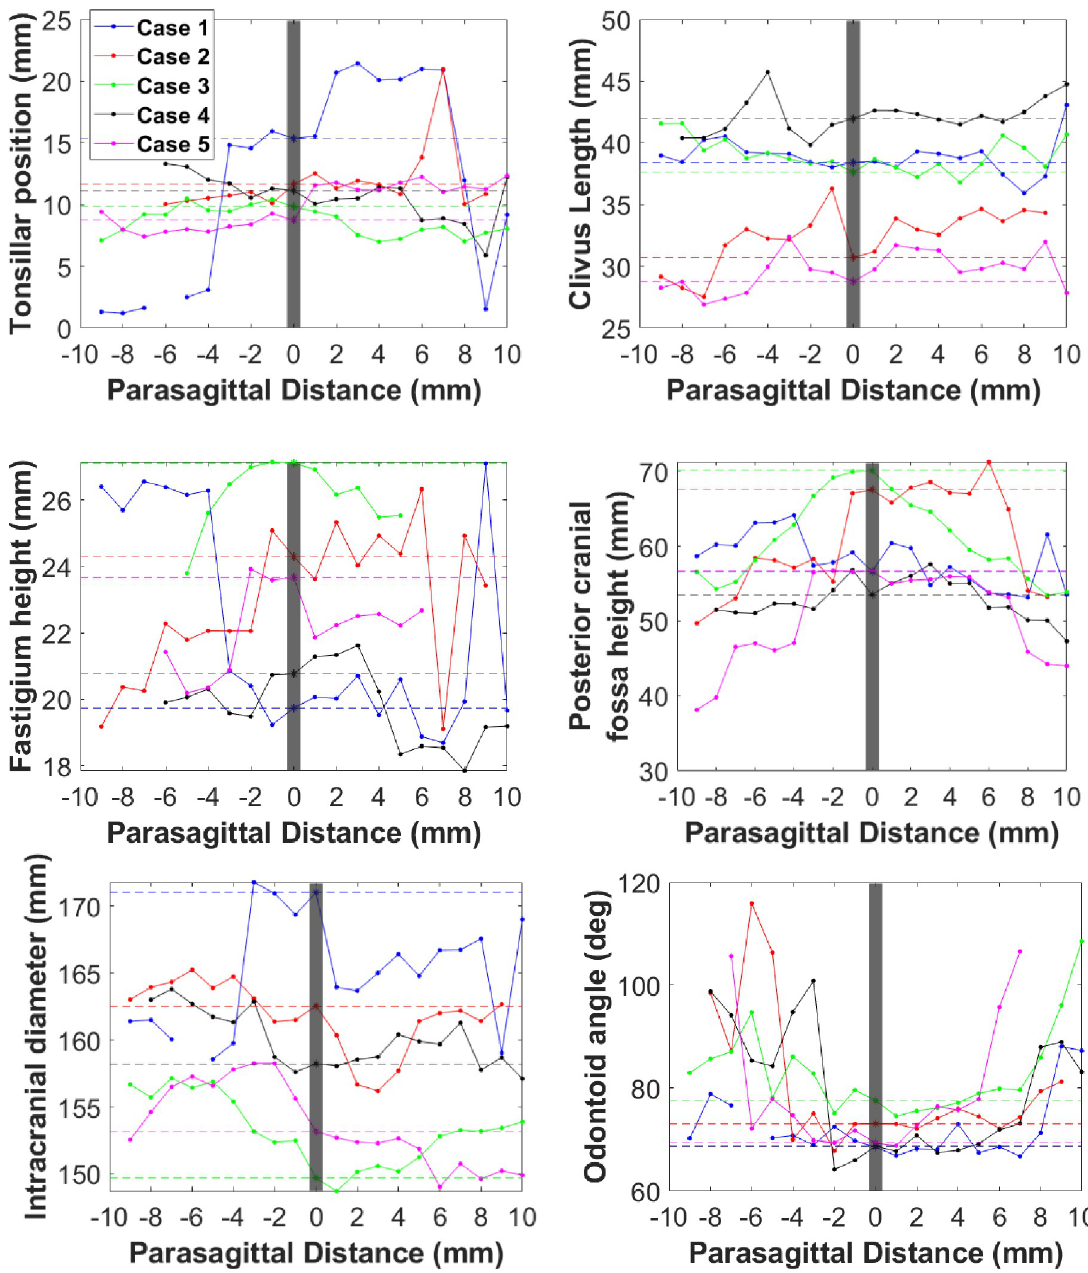
Fig 7. Symmetry plots showing parameters that demonstrate large lateral asymmetry from the midsagittal